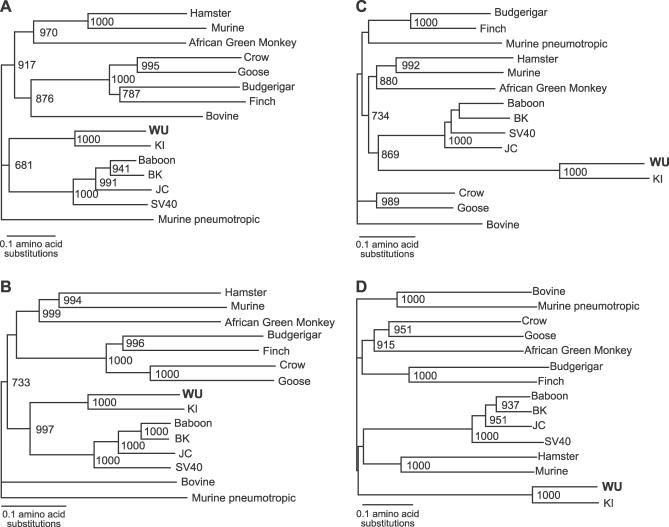
Phylogenetic Analysis of WU VirusAmino acid–based phylogenetic trees were generated using the neighbor-joining method with 1,000 bootstrap replicates. Significant bootstrap values are shown. A) STAg; B) LTAg; C) VP1; D) VP2.